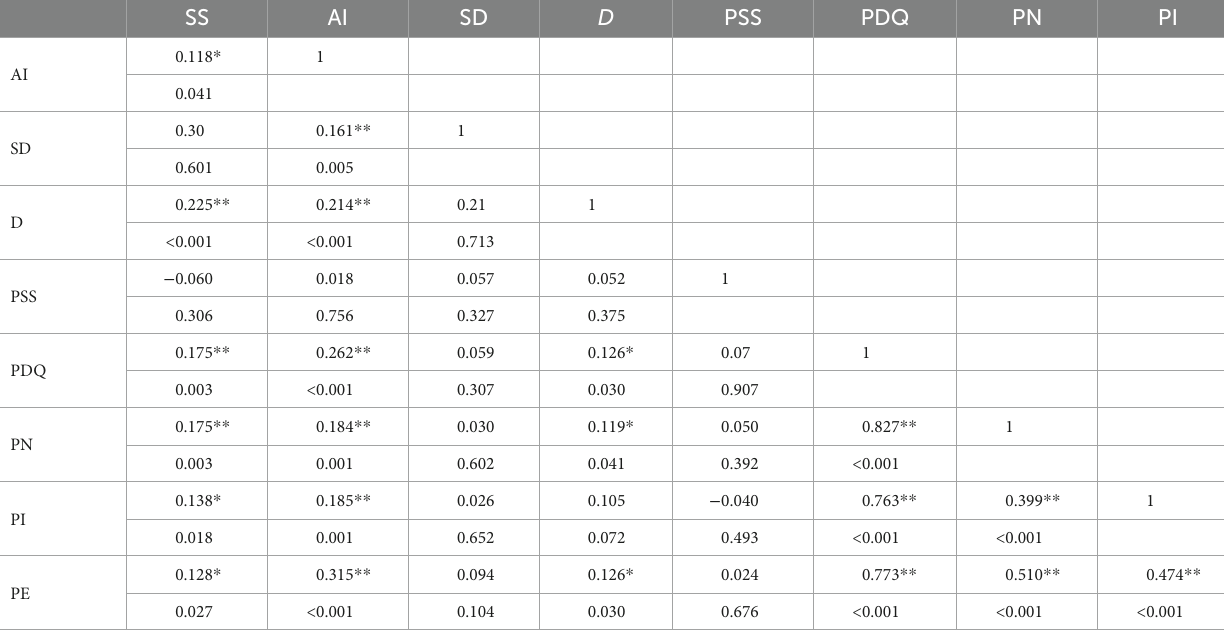
TABLE 5 Spearman inter-scale correlations between all variables included in the present study.